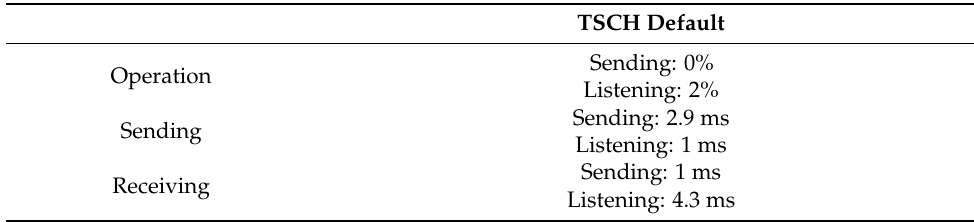
Table 2. The theoretical time a node’s radio is on while operating the TSCH RDC protocol and sending/receiving